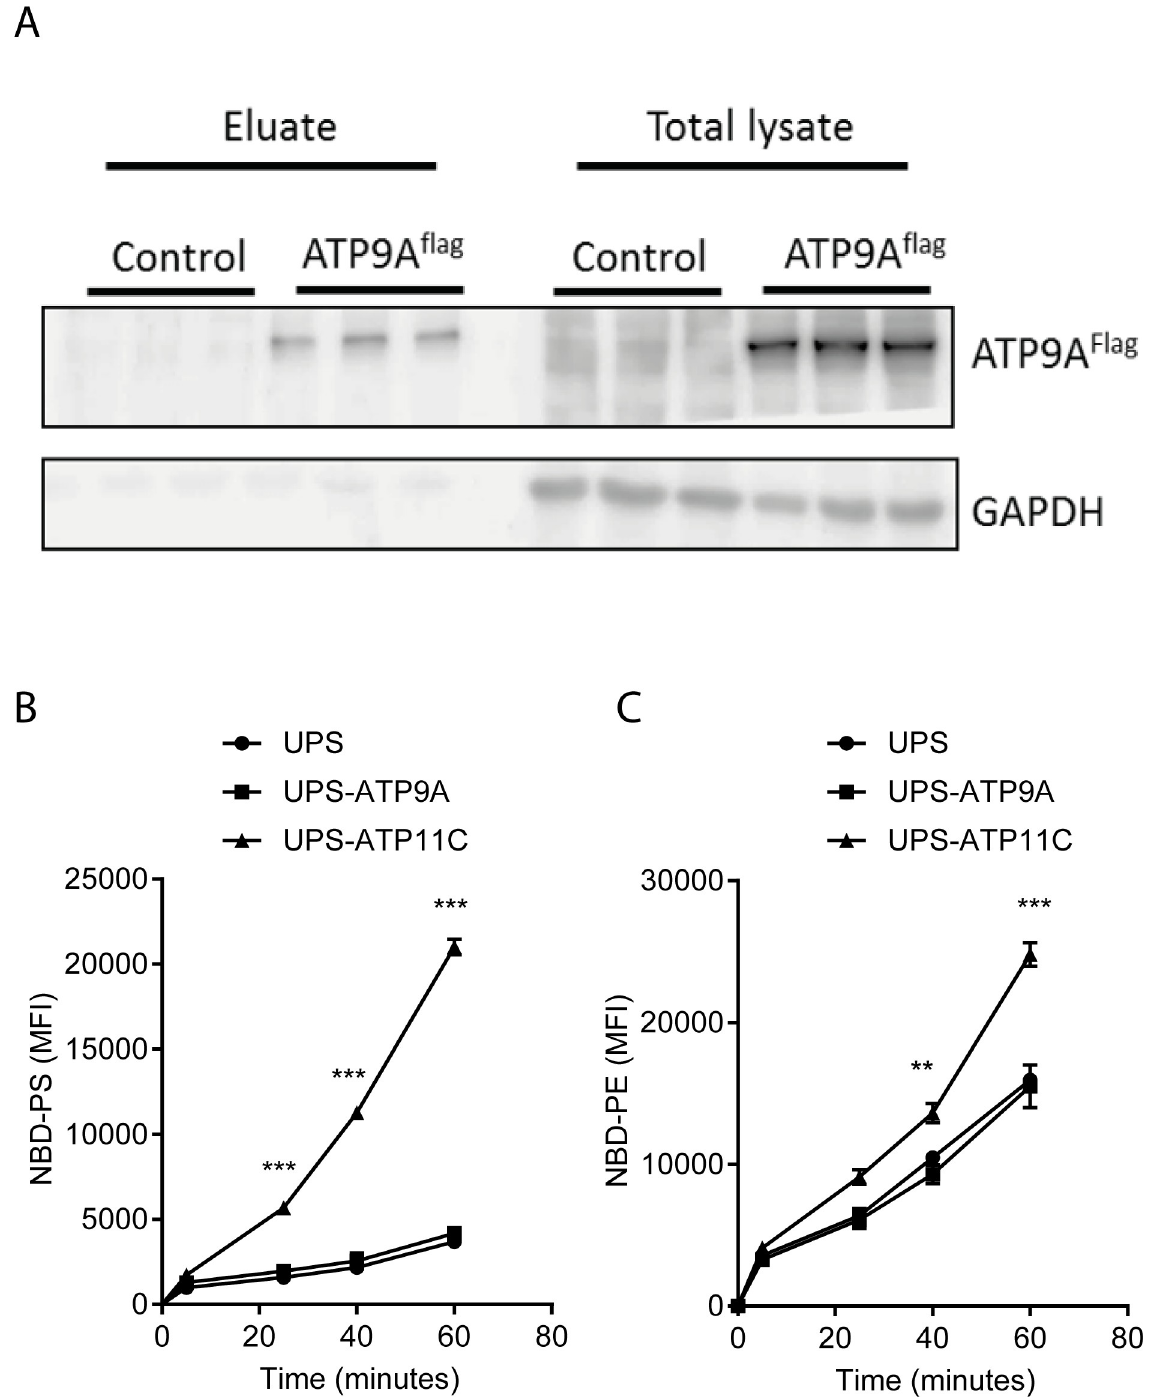
Fig 7. ATP9A does not transport NBD-labeled phospholipids. (A) UPS-1 cells overexpressing ATP9A-flag (UPS-ATP9A flag ) and control cells were incubated with 1 mg/ml sulfur-NH-ss-biotin for 1 hour. Biotinylated proteins were isolated and the presence of ATP9A-flag and GAPDH was analyzed by Western blot. (B and C) UPS-ATP9A flag cells were incubated with NBD-PS and NBD-PE respectively for 15, 30 and 60 minutes and internalization of NBD–phospholipids was analyzed by FACS. Mean fluorescent intensity of (B) NBD-PS, (C) NBD-PE was plotted over 60 minutes. Statistical significance was determined by one-way ANOVA with Bonferroni correction for multiple testing. � p < 0.05, �� p < 0.005.